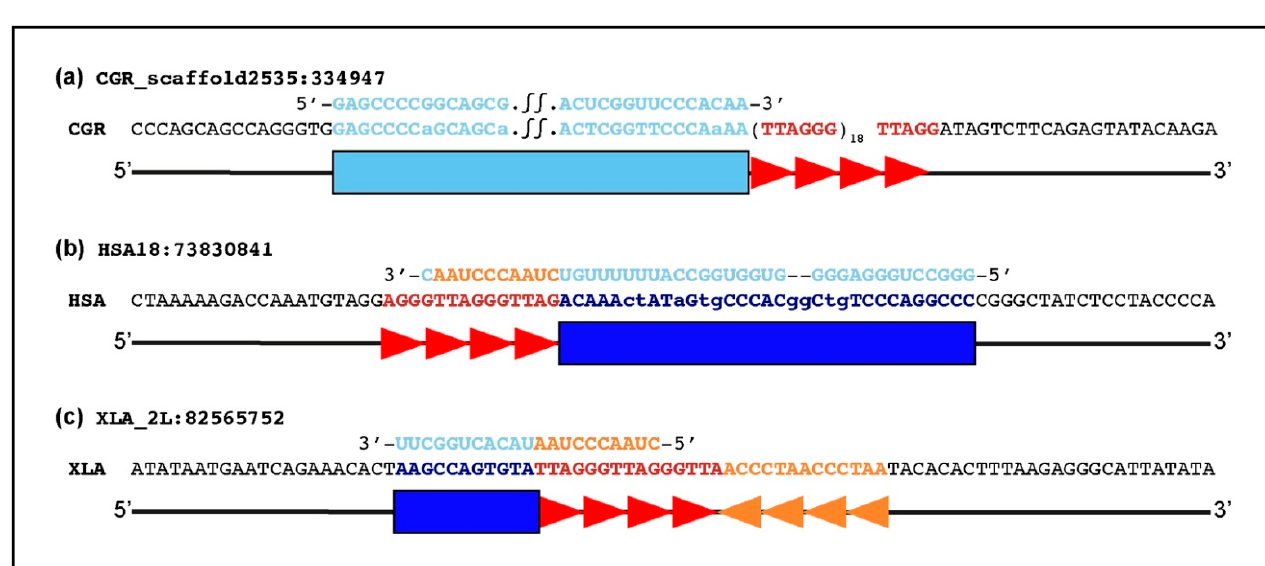
Figure 4. Organization of TERC-ITS loci. Sketches show the position and orientation of TERC-like sequences relative to TTAGGG repeats. Telomeric repeats in TTAGGG and CCCTAA orientation are indicated in red and orange, respectively. The TERC-like sequences homologous to a region of the telomerase RNA are indicated in light blue and the sequence complementary to a region of the telomerase RNA is in dark blue. ( a ) Organization of TERC-ITSs found in rodents, lemurs, lagomorphs, artiodactyls, perissodactyls, elephants, barn swallows, and cloudy catsharks (locus number 40). The Chinese hamster locus number 27 is shown as an example. The TERC-like sequence is upstream of the telomeric repeat array, and the two sequences are in an opposite orientation. Loci with this organization are marked with A in Table S2. ( b ) Organization of the TERC-ITSs found in Simiiformes primates, tiger pufferfish, and cloudy catsharks (locus number 41). Primate locus number 2 is shown as an example. The TERC-like sequence is downstream of the telomeric repeat array, and the two sequences are in the same orientation. Loci with this organization are marked with B in Table S2. ( c ) Organization of the TERC-ITS found in Xenopus laevis . The TERC-like sequence is positioned upstream of two stretches of telomeric hexamers organized head-to-head. This locus is marked with C in Table S2.